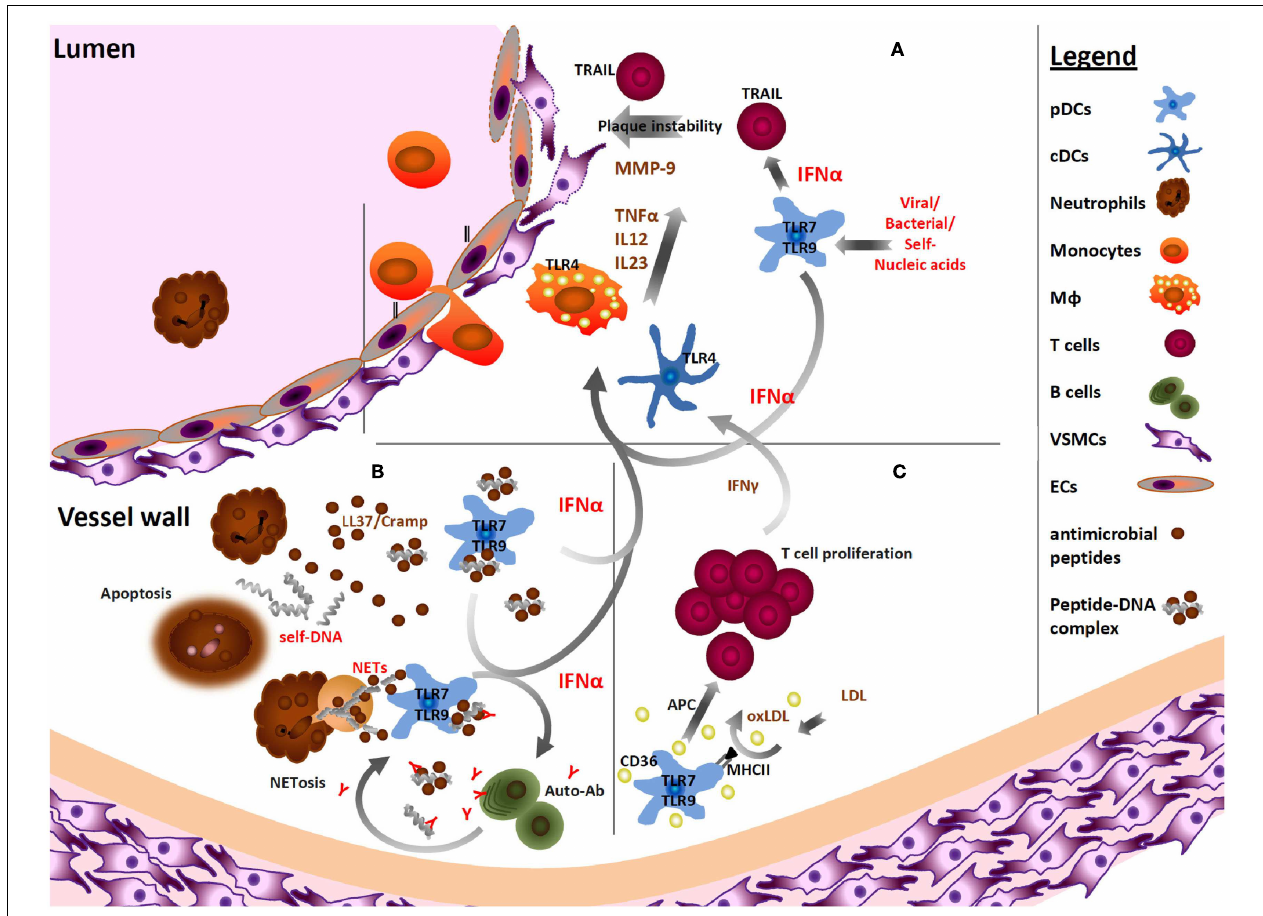
FIGURE 1 | Plasmacytoid DCs in atherosclerosis. (A) pDCs activated by nucleic acids of viral, bacterial or self-origin viaTLR7 andTLR9 produce robust amounts of IFN α .This cytokine enhances the sensitivity of other antigen presenting cells by upregulation ofTLR4. Furthermore, IFN α upregulates the expression of the pro-apoptotic moleculeTRAIL on CD4 + T cells, thereby multiplying their cytotoxic potential.TheseTRAIL-expressingT cells have the ability to kill plaque-resident cells such as vascular smooth muscle cells (VSMCs) and endothelial cells (ECs). IFN α activates cDCs and macrophages (M φ ) to produce effector molecules such as metalloproteinases (MMP) degrading the extracellular matrix, and proinflammatory cytokines, such as IL-12,TNF α or IL-23 (Niessner andWeyand, 2010). (B) The antimicrobial peptides LL37/Cramp secreted by infiltrating neutrophils bind